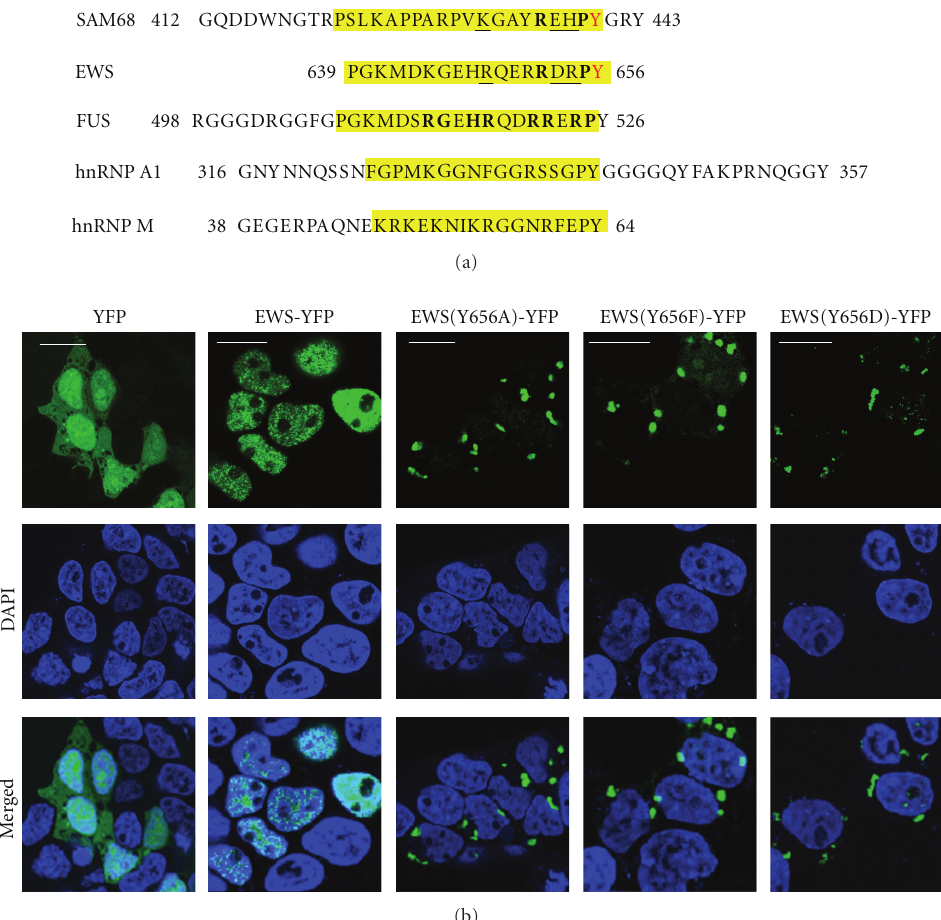
Figure 1: (a) Sequence alignment of PY-NLSs. The homologous regions of C-NLS of the EWS protein, NLS of Sam68 and FUS/TLS protein and M9 NLS of hnRNP A1 and hnRNP M, classified as PY-NLS are in yellow boxes. Phosphorylated Y656 of the EWS protein and Y440 of Sam68 are indicated (in red). Positions of identical residues in SAM68 and EWS C-NLS are indicated in bold and residues with identical charges are underlined. Known positions of the FUS/TLS mutations in ALS are in bold. (b) Subcellular localization of YFP, the C-terminally tagged EWS-YFP, EWS(Y656A)-YFP, EWS(Y656F)-YFP, and EWS(Y656D)-YFP (in green). Nuclei are shown by DAPI staining (in blue). Bars, 15 μ